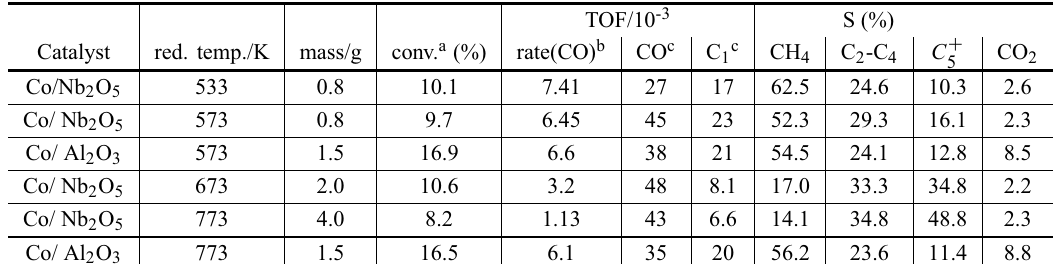
Influence of the reduction temperature (K) on activity and selectivity (Rosenir et al. 1993).